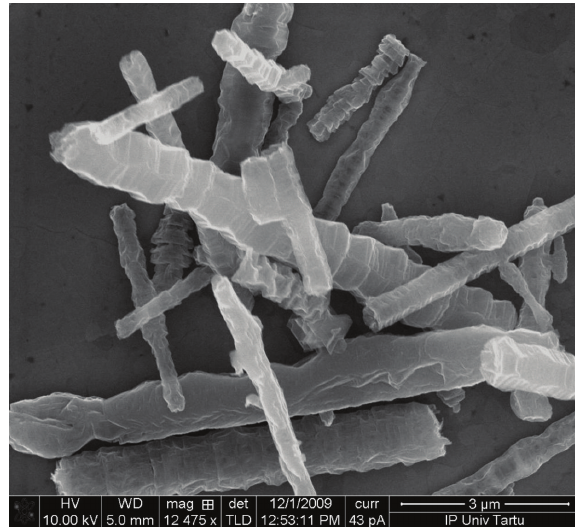
Figure 1: SEM image of the SCNRs, magnified 2513x. Figure 2: SEM image of the SCNRs, magnified 12475x.